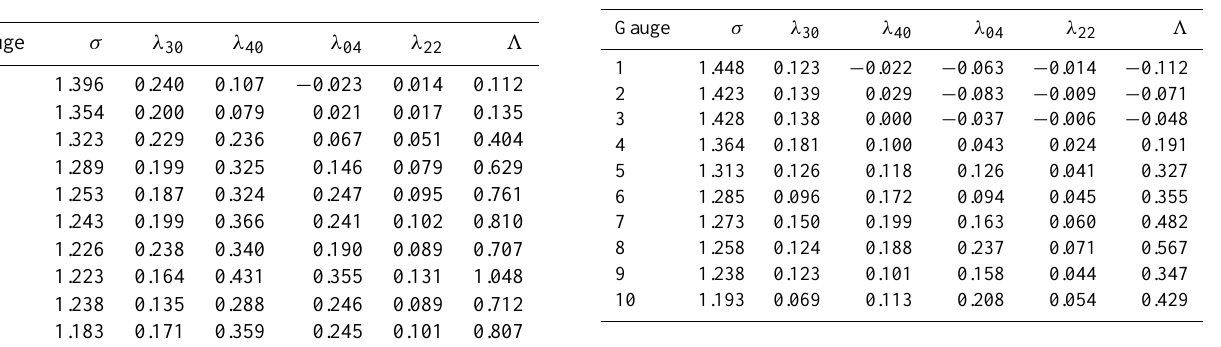
Table 6. Overall statistical averages from 15min segments for 8231: H s =3.6/3.6m, T p